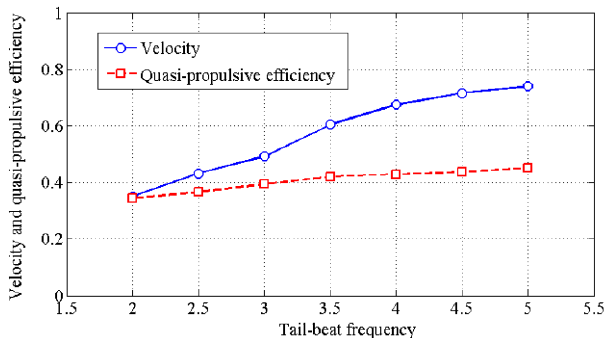
Figure 15. Effects of tail-beat frequency on the swimming performance of carangiform fish.